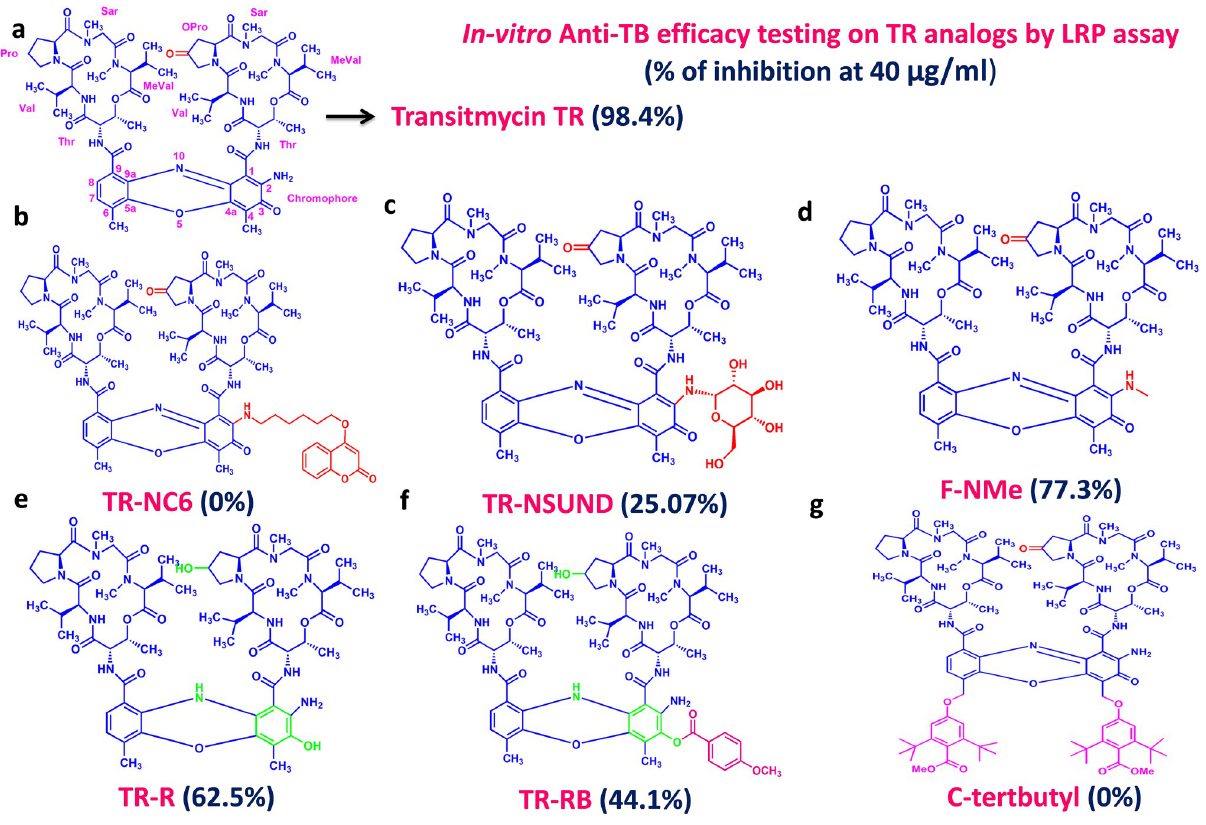
Fig 5. In-vitro anti-TB efficacy testing on TR analogues by LRP assay.